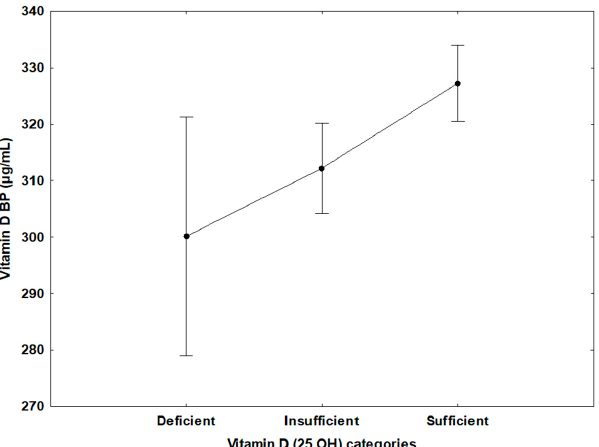
Figure 1. Using the Endocrine Clinical Society Practice Guidelines for vitamin D deficiency, vitamin D-binding protein (µg/mL) levels were found to be significantly decreased in the deficient vitamin D group, mean ± SD, 311 ± 75 ( µ g/mL) ( N = 431), compared to the insufficient vitamin D group, 327 ± 85 ( N = 408), and the optimal vitamin D group, 328 ± 75 ( N = 126), ( p = 0.007). BP, binding protein.